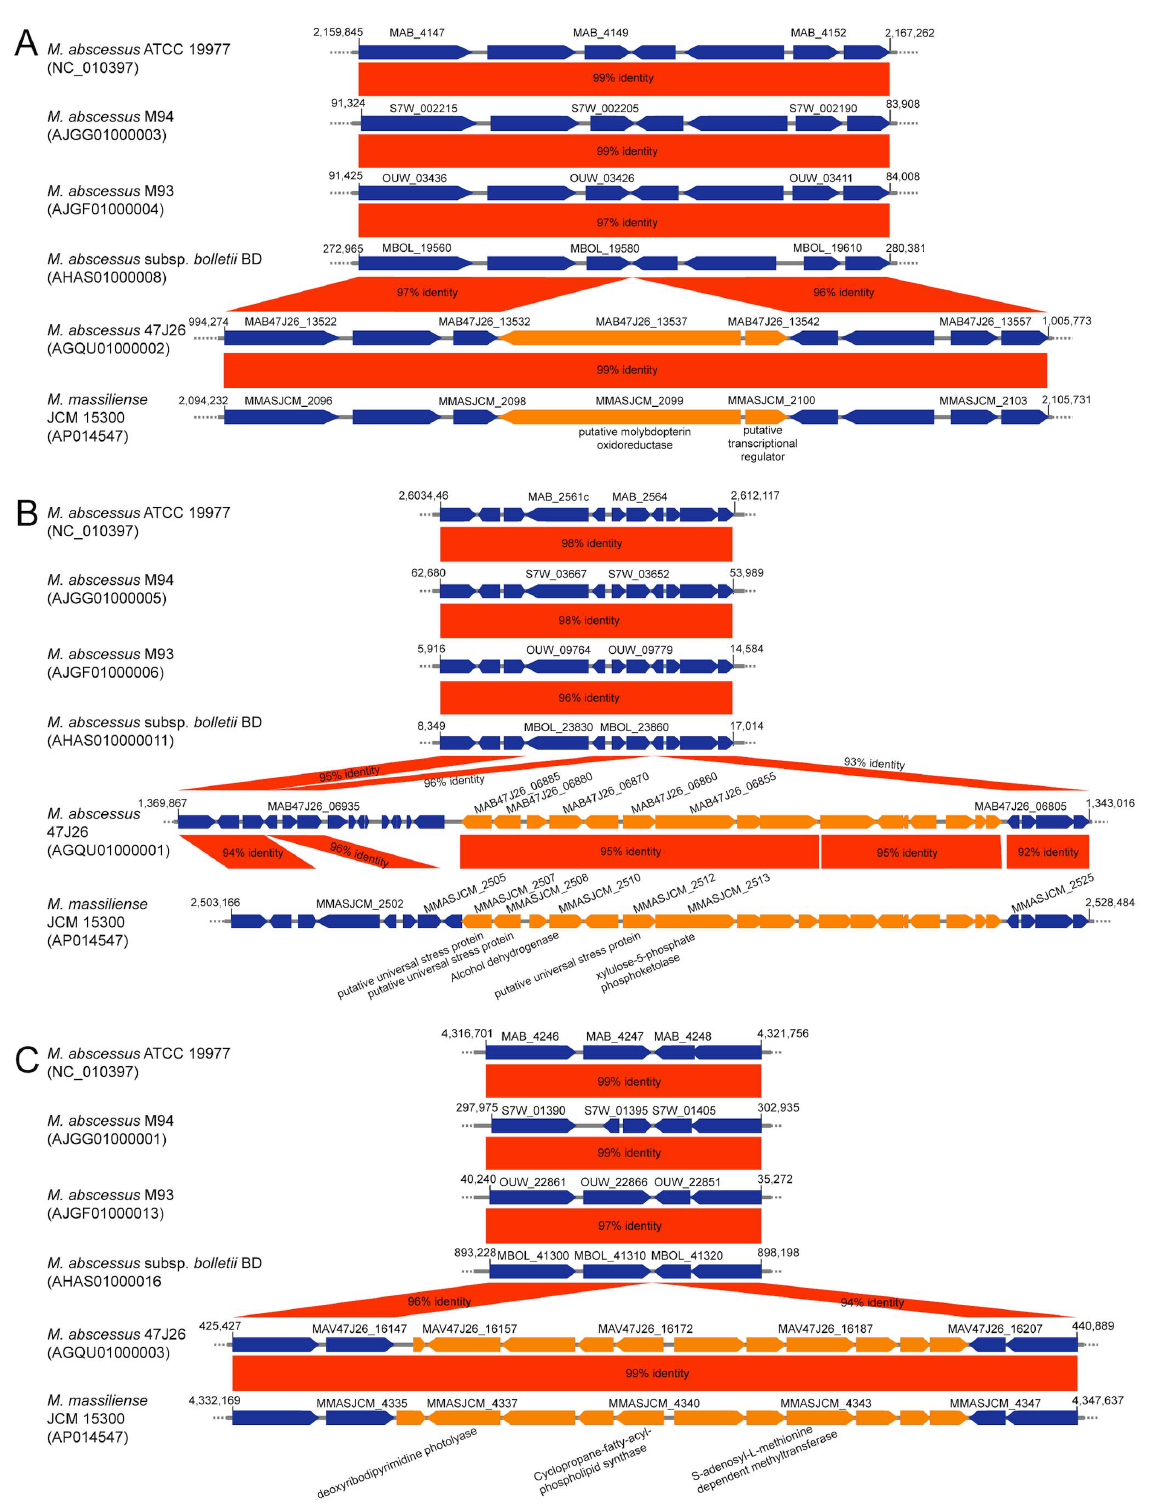
Fig. 4. Comparison of unique genes and flanking regions in the massiliense cluster. GenBank accession numbers are given in parentheses. The orange arrows indicate the unique genes in the massiliense cluster. BLASTN match scores less than 200 are not shown.